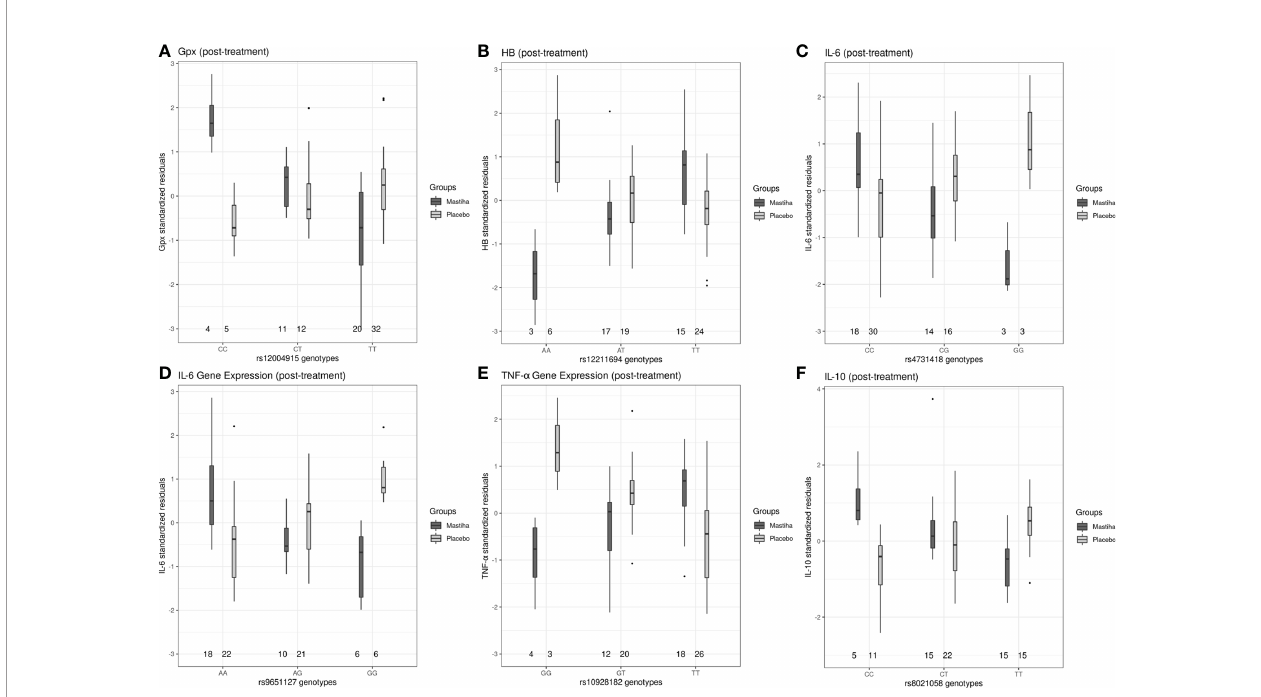
FIGURE 2 | Boxplots of selected post-treatment levels (adjusted for the baseline levels, age, sex, center and the fi rst 5 genetic principal components) between the Mastiha and placebo groups, strati fi ed by genotype, for the signi fi cant gene-by-Mastiha interactions (outliers are presented as dots: (A) Gpx levels by the rs12004915 genotypes, (B) HB by rs12211694, (C) IL-6 by rs4731418, (D) IL-6 by rs9651127, (E) TNF- a by rs10928182 and (F) IL-10 by